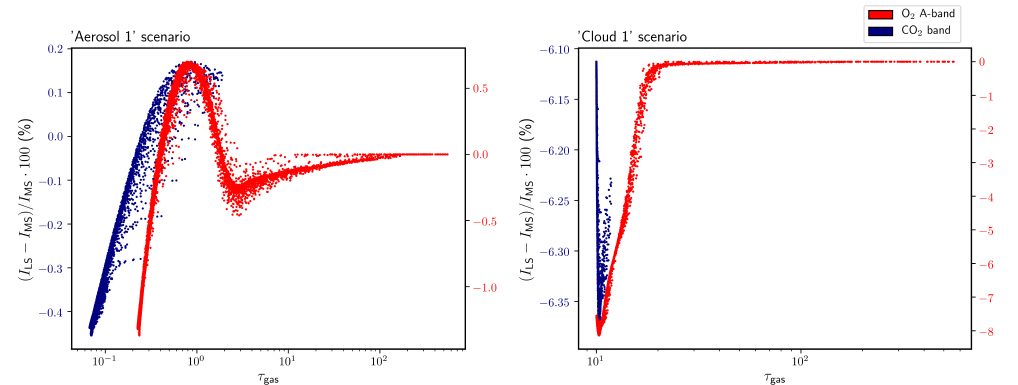
Figure 1. Relative errors of the two-stream model as a function of the gas optical depth ( τ gas ) for the O 2 A-band (red) and CO 2 band (blue). Left panel corresponds to the ‘Aerosol 1’ scenario, while right panel shows the results for the ‘Cloud 1’ scenario. Note that left Y axis refer to CO 2 while right Y axis refer to O 2 A-band.